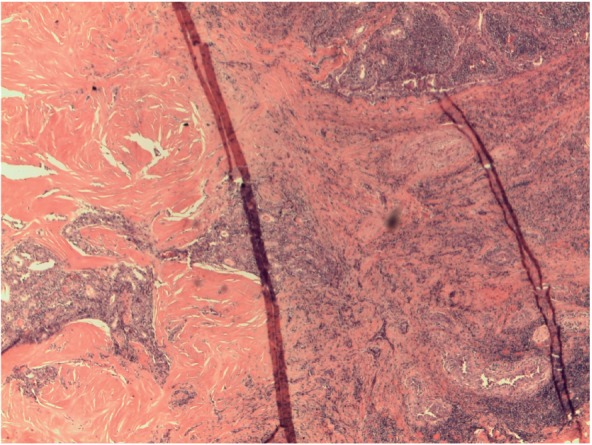
Papillary carcinoma with only sclerosing areas.